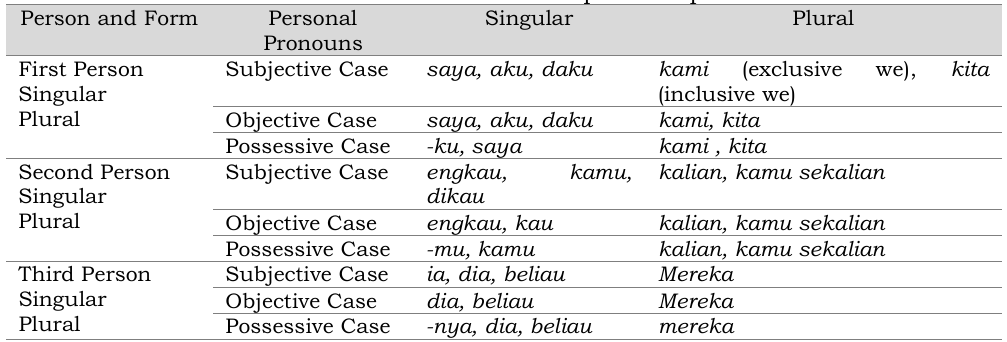
Table 2. The form of Indonesian personal pronouns